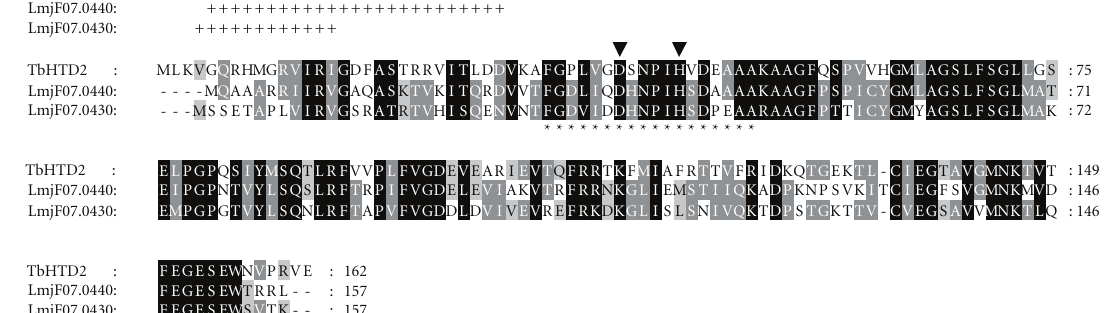
Figure 1: Similarity of L. major LmjF07.0440 and LmjF07.0430 to their T. brucei homologue, Tb HTD2. Explanations for this and Figure 3 are given. Multalin- and Genedoc-based comparison of the deduced amino acid sequences is provided. Dashes indicate the arrangement of the sequences for best fit. Black shadings refer to conserved amino acid residues among all three sequences whereas the darker and lighter grey shadings denote regions with more relaxed residue similarities not necessarily shared by the full set of sequences. MitoProt predictions of cleaved mitochondrial leader sequences are indicated (+). Active site residues of human mitochondrial dehydratase D62 and H67 are denoted ( (cid:2) ), whereas the hydratase 2 domain is underscored ( ∗ ). The sequences used for the Leishmania proteins throughout this work were retrieved from GeneDB of the Sanger Institute, whereas the accession number for Tb HTD2 was Q580H9